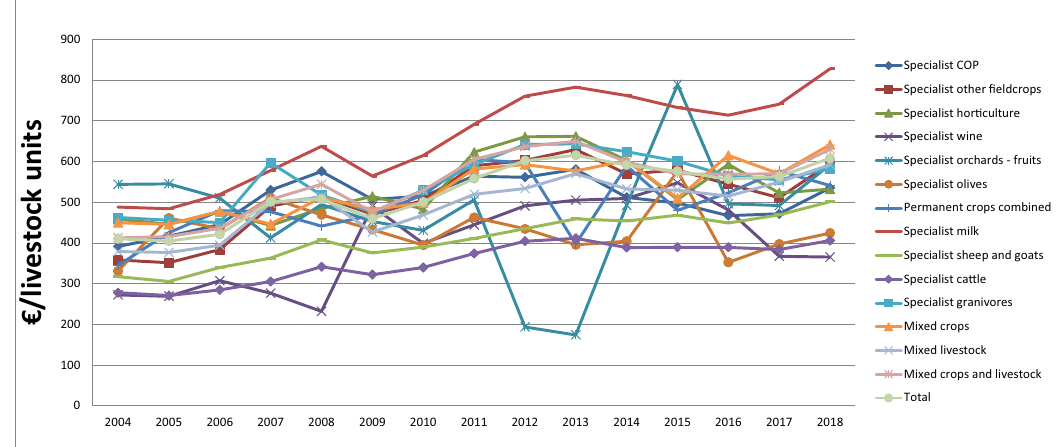
Figure 9: Speci fi c livestock costs ( € ) , per farm, for several farm types, for the period 2004 – 2018.